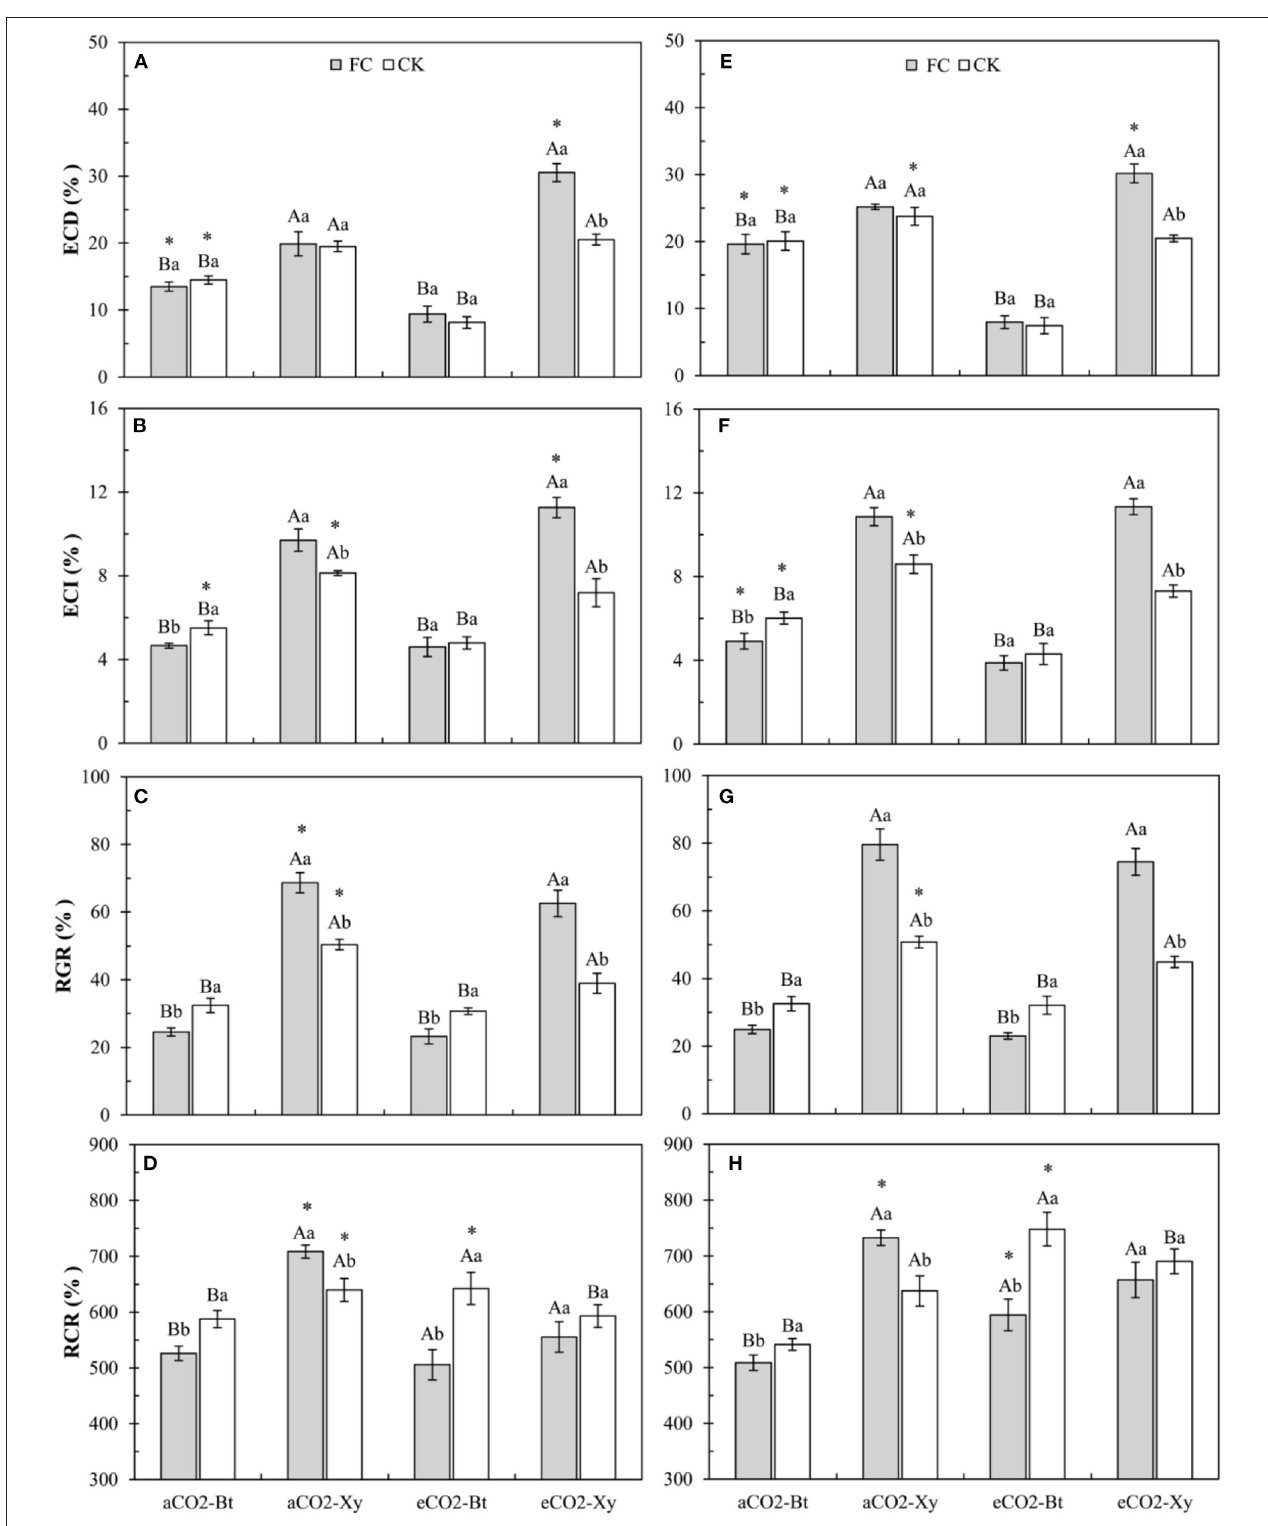
FIGURE 4 | Effects of the inoculation with arbuscular mycorrhizal fungi (AMF), F. caledonium , on the food utilization of M. separata larvae fed on Bt maize (Bt) and its parental line of non- Bt maize (Xy) under ambient CO 2 ( a CO 2 ) and elevated CO 2 ( e CO 2 ) at the heading stage (BBCH-59) in 2017 (A–D) and 2018 (E–H) . (Note: the same as Figure 3 ) ( P < 0.05; n =